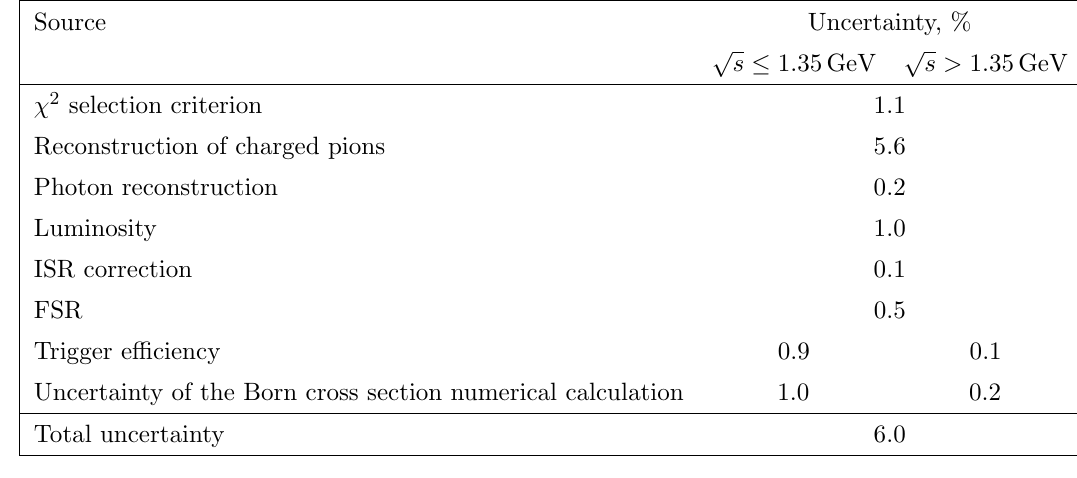
Table 3 . The sources of the systematic